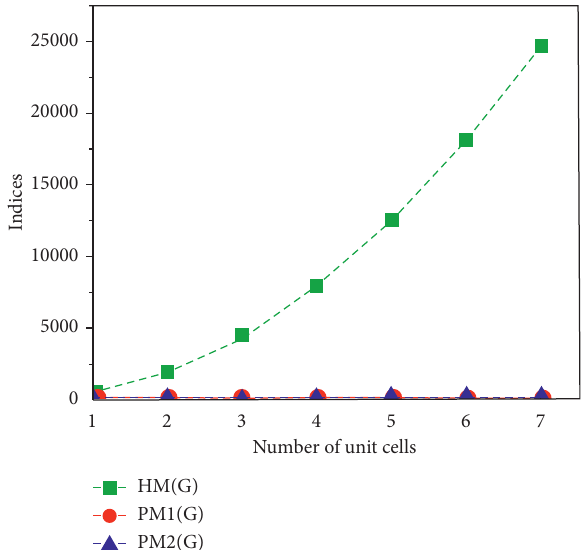
Figure 3: HM ( G ) ,PM